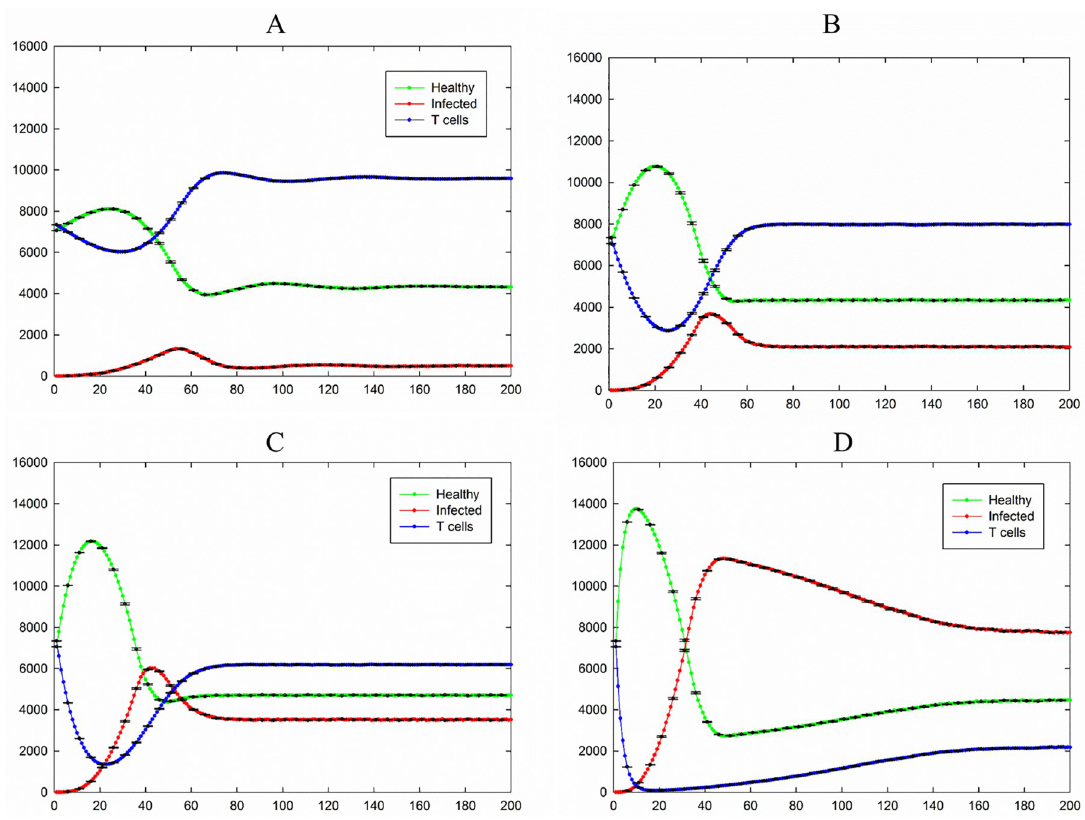
Fig 7. Total number of healthy, infected, and T cells versus time for the case of P I = 1.0, P T = 0.2, and P H = 0.2. A) P D = 0.01, B) P D = 0.05, C) P D = 0.1, D) P D = 0.3. Healthy, infected, and T cells are shown in green, red, and blue, respectively. The standard errors are shown by error